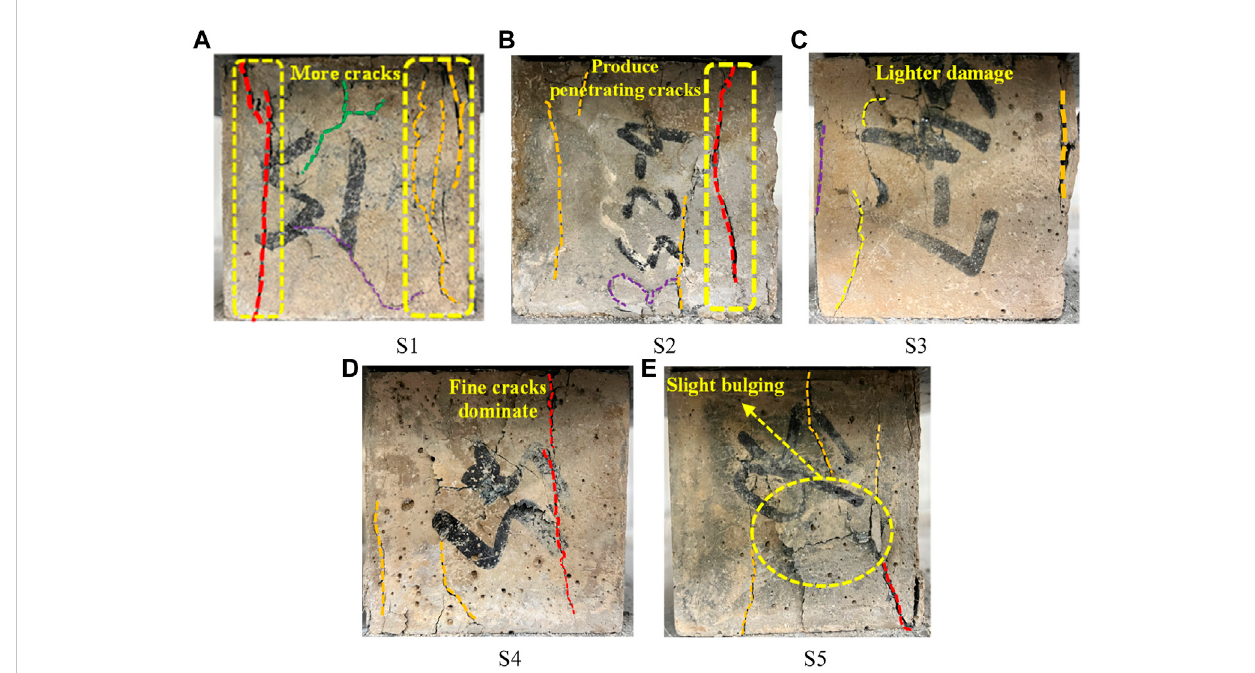
FIGURE 2 Axial compression failure patter. (A) Axial compression failure phenomenon of S1 specimens. (B) Axial compression failure phenomenon of S2 specimens. (C) Axial compression failure phenomenon of S3 specimens. (D) Axial compression failure phenomenon of S4 specimens. (E) Axial compression failure phenomenon of S5 specimens.